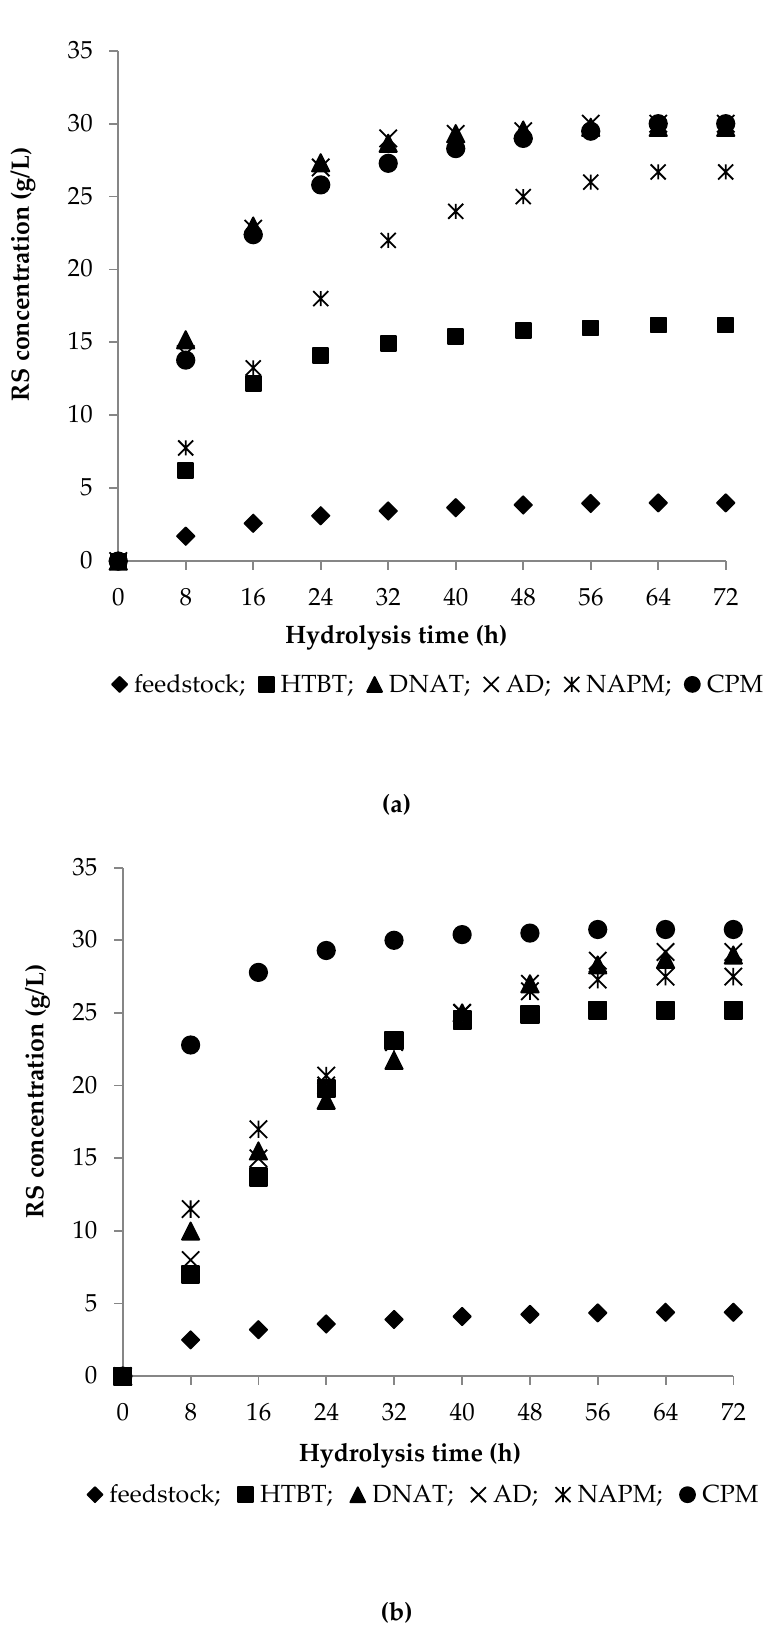
Figure 3. Time course of reducing sugars (RS) concentration in enzymatic hydrolysis of native feedstocks and pretreatment products: ( a ) Miscanthus and ( b ) oat hulls. Table 2. Characteristics of hydrolyzates obtained after 72 h of enzymatic hydrolysis (acetate buffer).